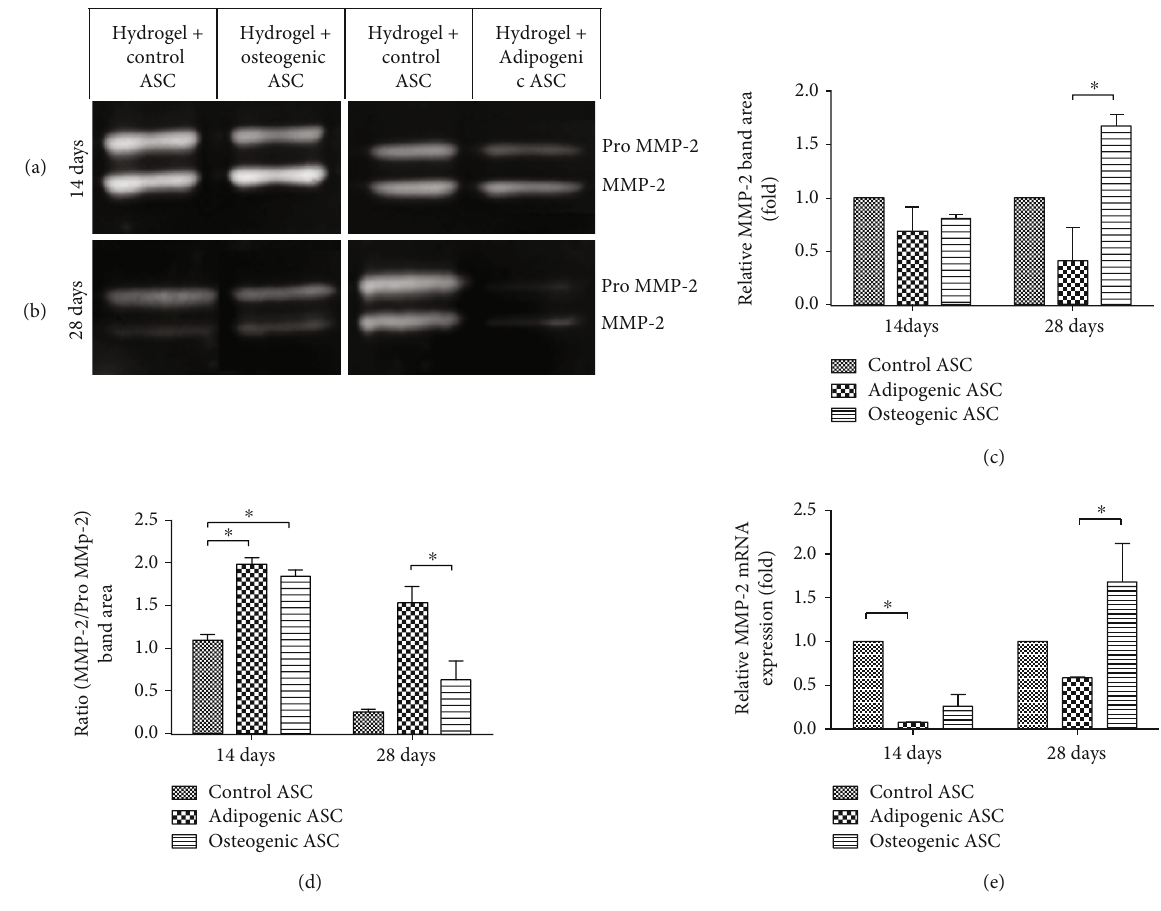
Figure 6: Analysis of MMP-2 expression by gelatin zymography and qRT-PCR. (a, b) Representative images of Pro MMP-2 and MMP-2 bands observed after gel electrophoresis of 14 (a) and 28 (b) day samples. (c) Pro MMP-2 and MMP-2 band area was determined by densitomteric analysis using ImageJ software, data are presented as fold change relative to the control samples. (d) Ratio of MMP-2 band area to Pro MMP-2 band area determined by densitometric analysis. (e) qRT-PCR analysis of MMP2 mRNA expression in control, adipogenic, and osteogenic samples are displayed as fold change relative to the control samples. Data are expressed as mean ( n = 6 ) ± SD; level of signi fi cance: ( ∗ ) p < 0 : 05